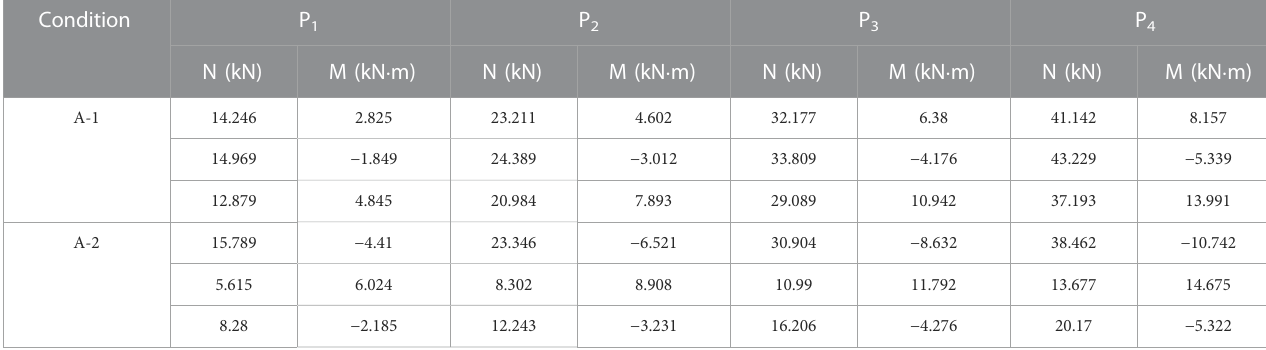
TABLE 7 First-order linear axial forces (N) and bending moments (M) calculated by fi nite elements.